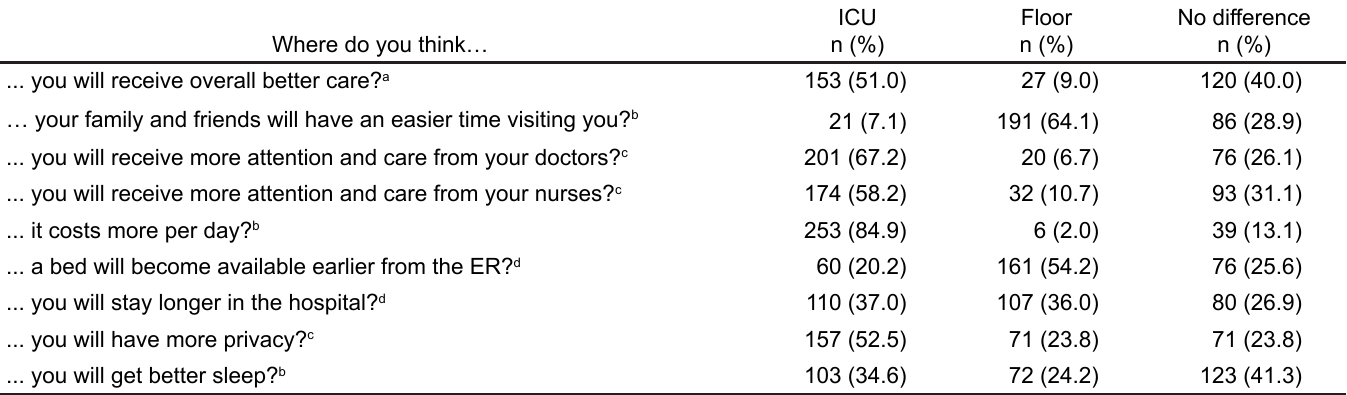
Table 3. Perceptions of care, n=302.